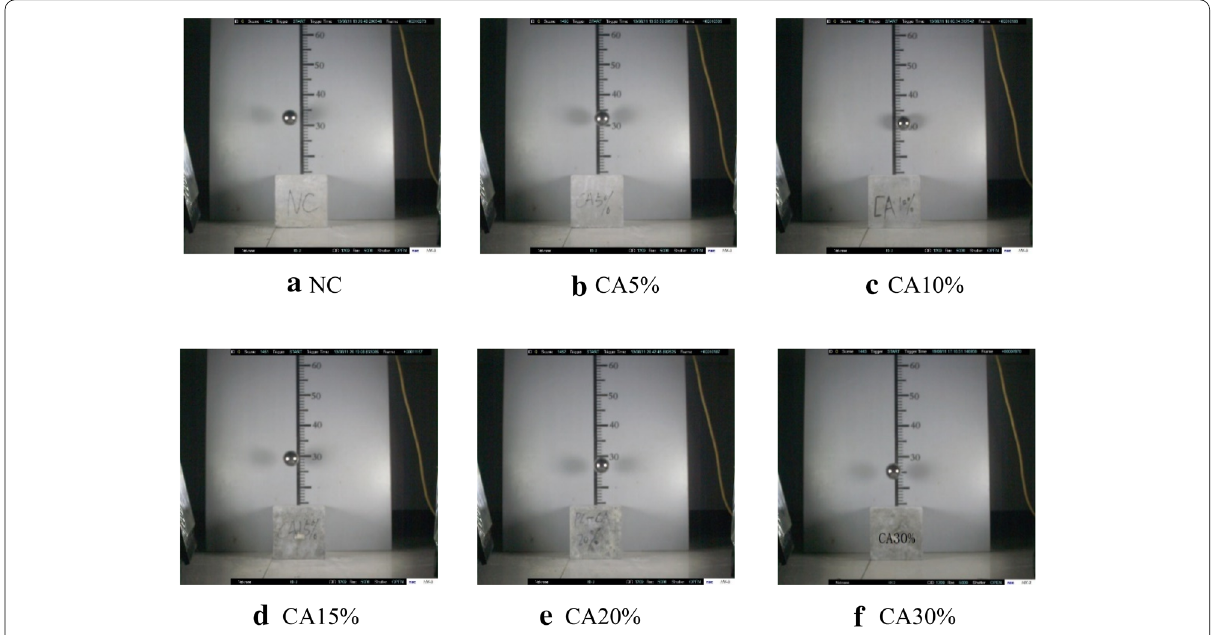
Fig. 9 Transient phenomenon of the highest rebound point.